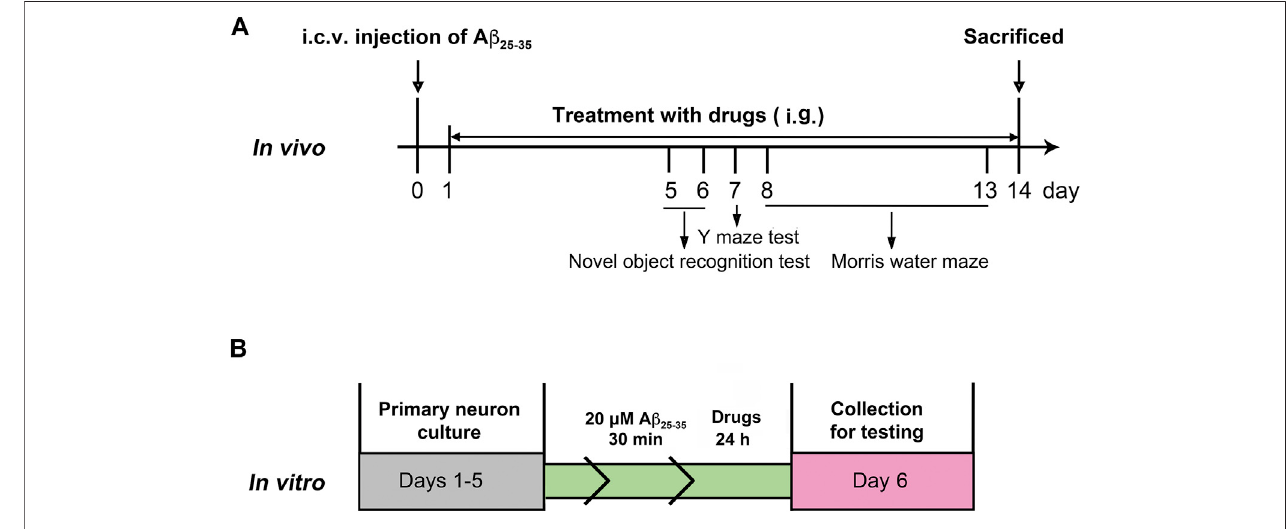
FIGURE 1 | Experimental protocols in vivo (A) and in vitro (B)